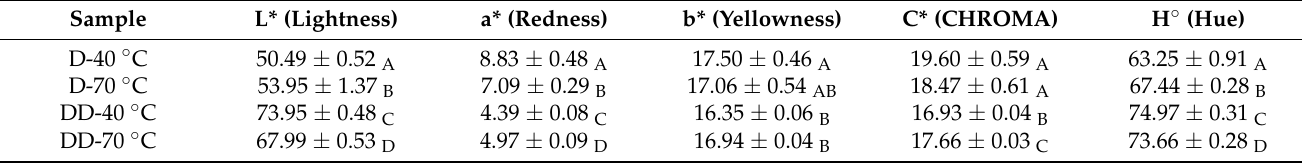
Table 3. CIE L*a*b* color parameters, chroma (C*) and hue (H ◦ ) of porcine liver dried at 40 ◦ C (D-40 ◦ C) and 70 ◦ C (D-70 ◦ C) and subsequently defatted (DD-40 ◦ C and DD-70 ◦